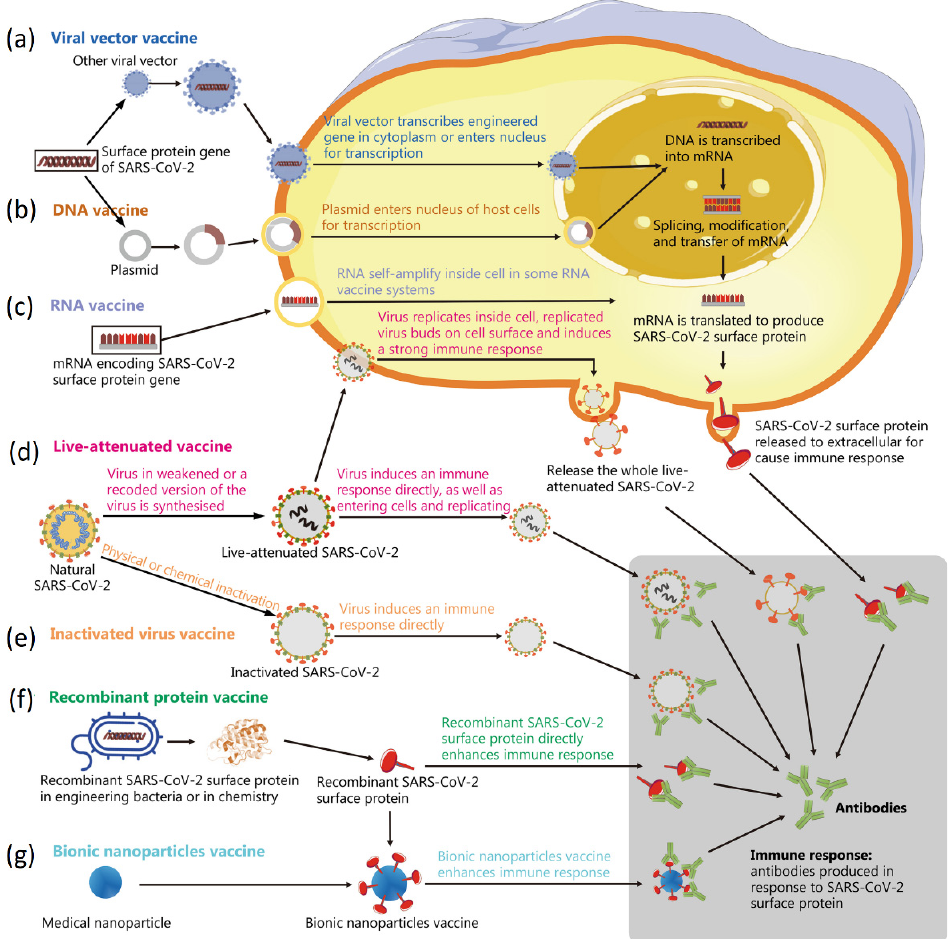
Figure 10. Schematic diagram showing the principles of various vaccines: ( a ) viral vector vaccine, ( b ) DNA vaccine, ( c ) RNA vaccine, ( d ) live-attenuated vaccine, ( e ) inactivated virus vaccine, ( f ) recombinant protein vaccine, and ( g ) bionic nanoparticles vaccine. Reprinted from [182], with permission from Elsevier.